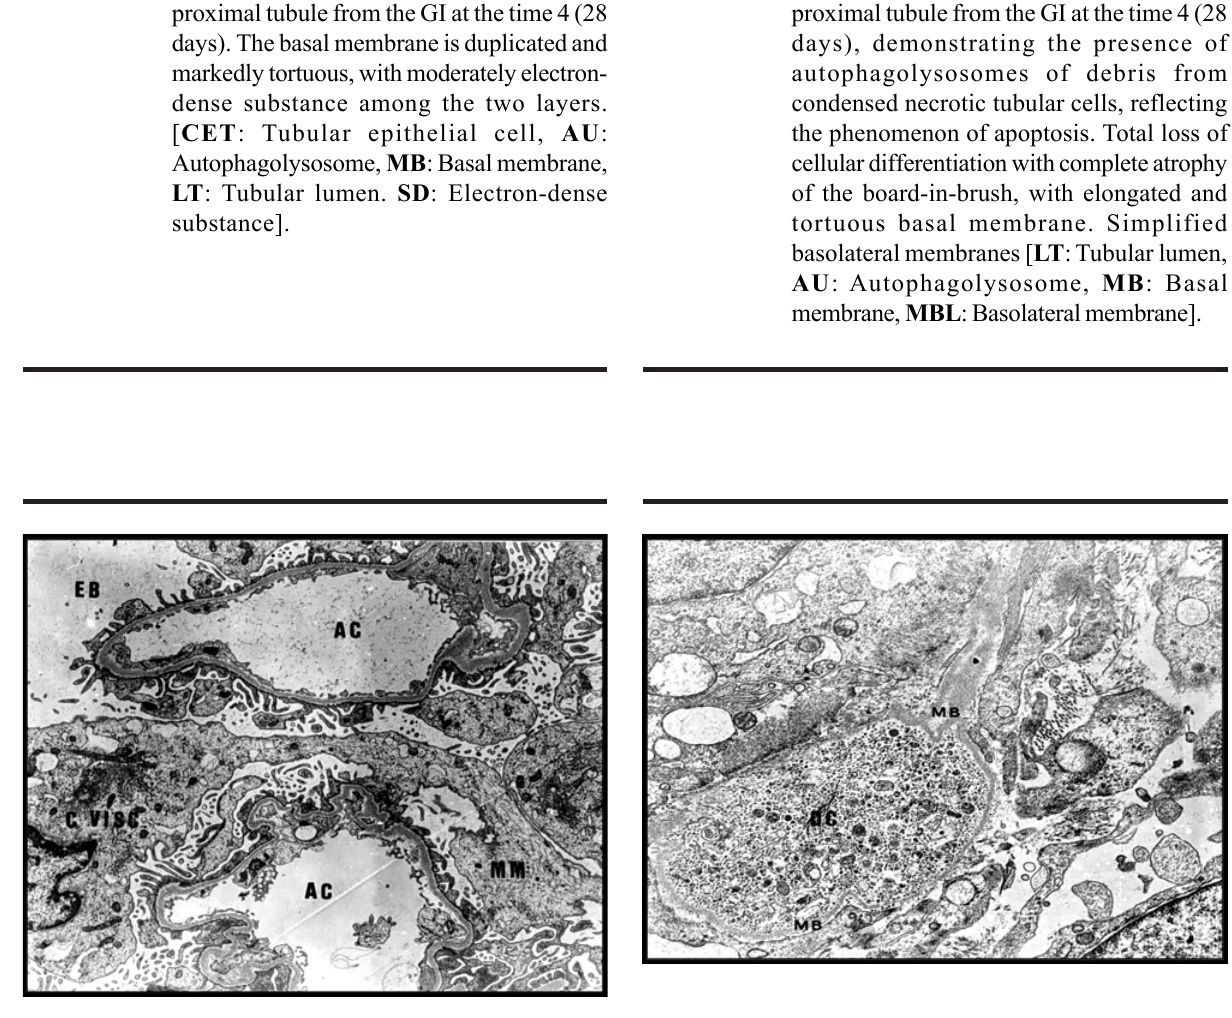
FIGURE 10 - Electronic photomicrography (7.500 X) of glomerulus from GI at the time 7 (49 days). The glomerulus is complete and with preserved architecture. [ AC : Capillary loop, MM : Mesangial matrix, EB : Bowman’s space,